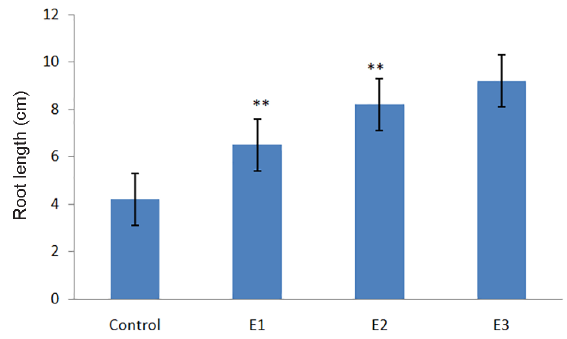
Figure 2. Comparison of root length between the experimental plants and control